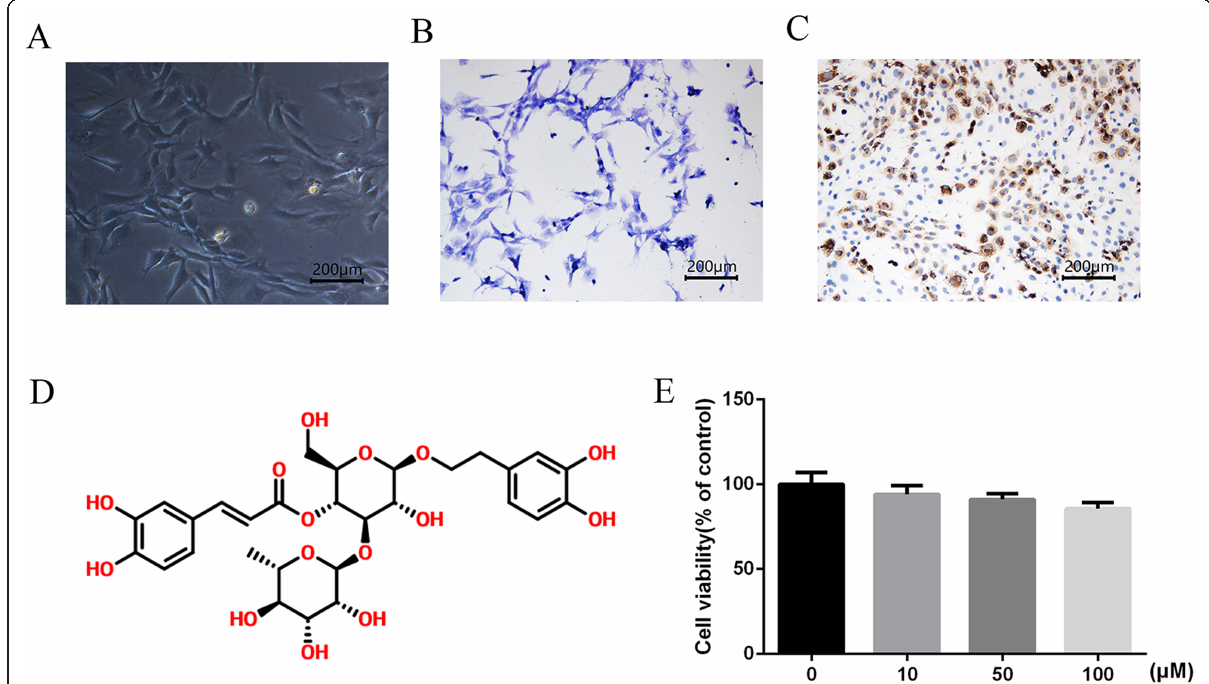
Fig. 1 ACT doesn ’ t affect primary chondrocyte cell viability. Rat primary chondrocytes were isolated and cultured in vitro. a Cell morphologies of chondrocytes were examined with a microscope. b Toluidine blue staining of primary rat chondrocytes. c Collagen II staining for primary rat chondrocytes were performed to identify the chondrocytes. d The molecular structure of ACT was shown. e Primary rat chondrocytes were treated with ACT (0, 10, 50, 100 μ M) for 24 h, CCK-8 assay was employed to detect cell viability. a - c were representative data from three independent experiments. e was representative result from three independent experiments with